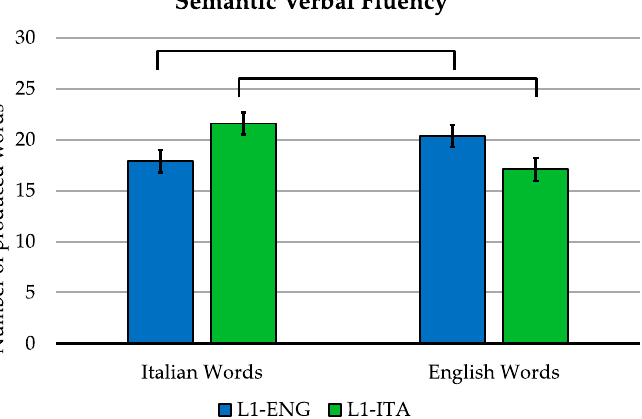
Figure 1. Semantic verbal fluency. Mean number of English and Italian words produced during the semantic verbal fluency tasks by L1-Italian and L1-English bilinguals. Error bars indicate the standard error of the mean.